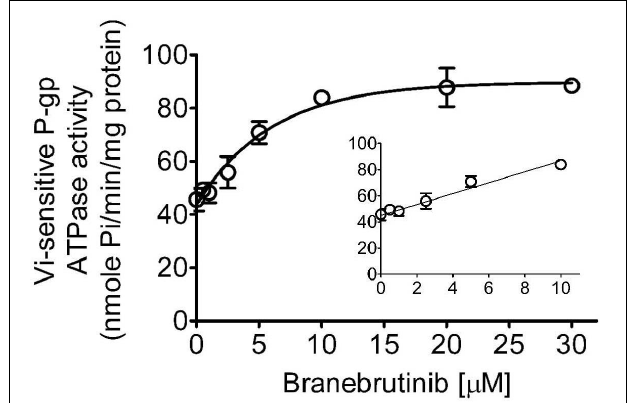
FIGURE 6 | Docking of branebrutinib in the drug-binding pocket of P-glycoprotein (P-gp). Binding modes of branebrutinib with the protein structure of P-gp (PDB: 6QEX) was predicted by Accelrys Discovery Studio 4.0 software as described in Materials and methods. Branebrutinib is shown as a molecular model with highlighted yellow color and the atoms for interacting amino acid residues were colored as oxygen-red, nitrogen-blue, hydrogen-light gray and carbon- gray. Proposed interactions are presented as dotted